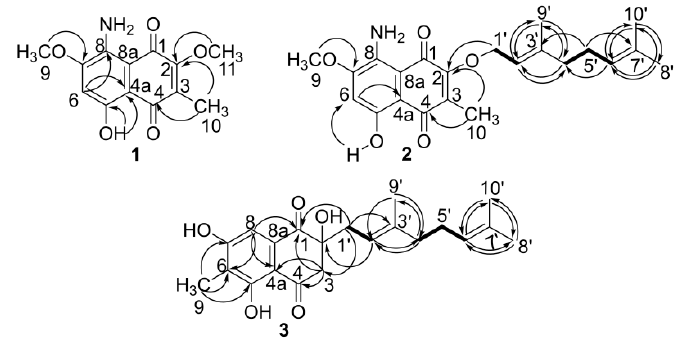
Figure 3. 1 H- 1 H COSY (bold lines) and HMBC correlation (arrows) supporting planar structures of 1 – 3 . Table 1. 1 H and 13 C-NMR, 1 H- 1 H COSY, gHMBC data of 1 (600 MHz, CDCl 3 ).